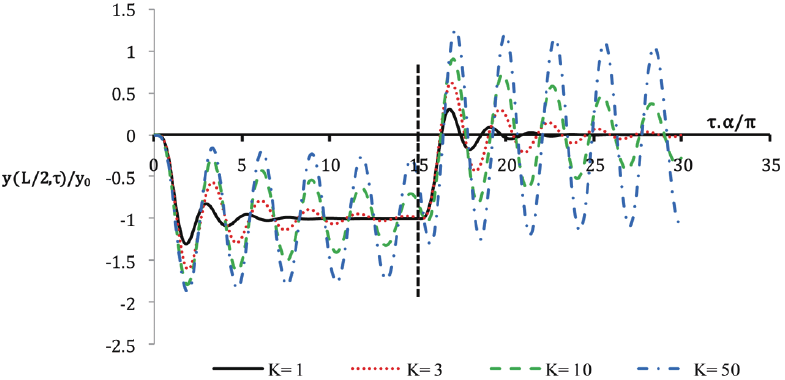
Fig. 8. DLF in terms of τ · α/π for α = 1, E 1 = 0.5 and K (cid:2)